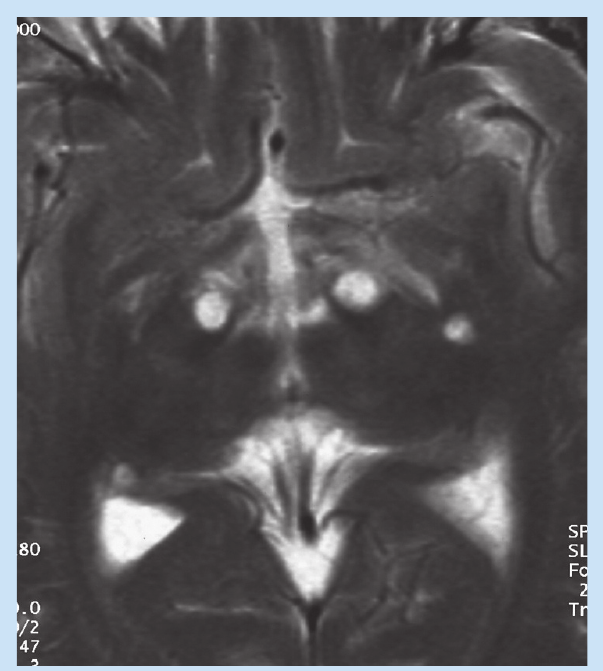
Fig. 4. Axial T2-weighted image with bilateral high signal intensity in the thalami.